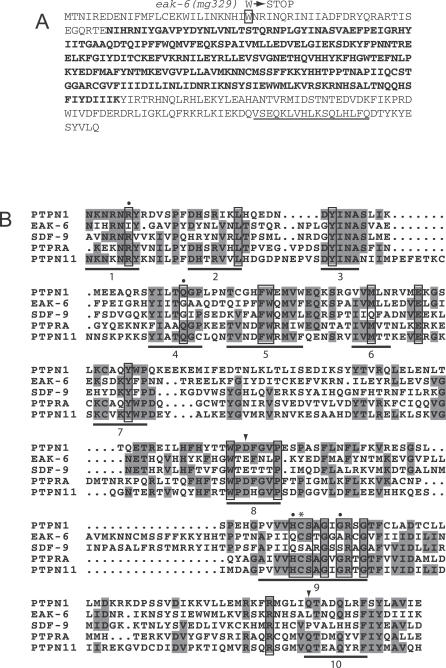
Predicted Primary Amino Acid Sequence of EAK-6 and Similarity with PTPs(A) EAK-6 amino acid sequence. EAK-6 sequence was derived from full-length cDNA amplified by RT-PCR from wild-type C. elegans total RNA. The PTP domain is denoted in boldface. The residue mutated in eak-6(mg329) is boxed and the predicted change indicated above the mutated residue. Amino acids encoded by an alternatively spliced exon present in EAK-6L but not in EAK-6S (see Materials and Methods) are underlined.(B) EAK-6 homology with PTPs. The PTP domain of EAK-6 is aligned with that of SDF-9 and 3 human PTPs. Sequences used in the alignment are based on domains defined by Pfam [101] and correspond to amino acids 40 to 276 of PTPN1 (PTP1B), 57 to 308 of EAK-6, 31 to 283 of SDF-9, 265 to 500 of PTPRA (receptor-type PTPα), and 273 to 520 of PTPN11 (SHP-2). Alignment was performed using ClustalX 1.8 and MacBoxshade 2.15. Conserved and identical residues are shaded. Ten motifs conserved among 37 vertebrate PTPs [68] are underlined, and 19 residues that are invariant among 113 vertebrate PTP domains are boxed. The four invariant residues that are not identical in EAK-6 (R45, Q85, H214, and G220, numbered according to the PTPN1 primary sequence) are denoted with dots. The catalytic cysteine residue [69] is denoted by an asterisk. Two conserved residues that are not conserved in EAK-6, D181 and Q262, are denoted by arrowheads.